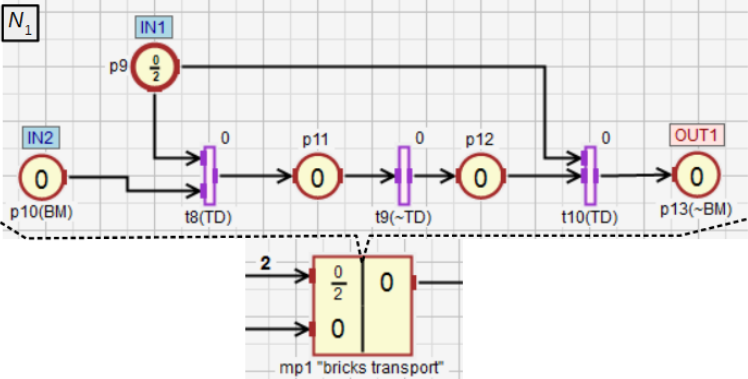
Figure 13. The brick transport module to the